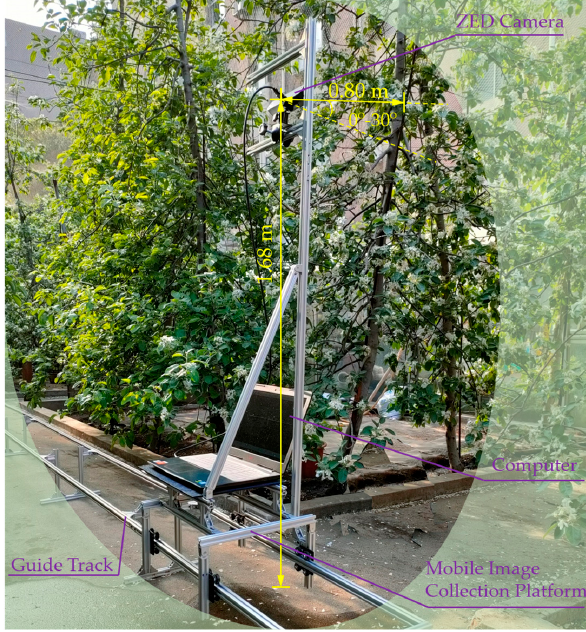
Figure 3. Image collection device and collection method.